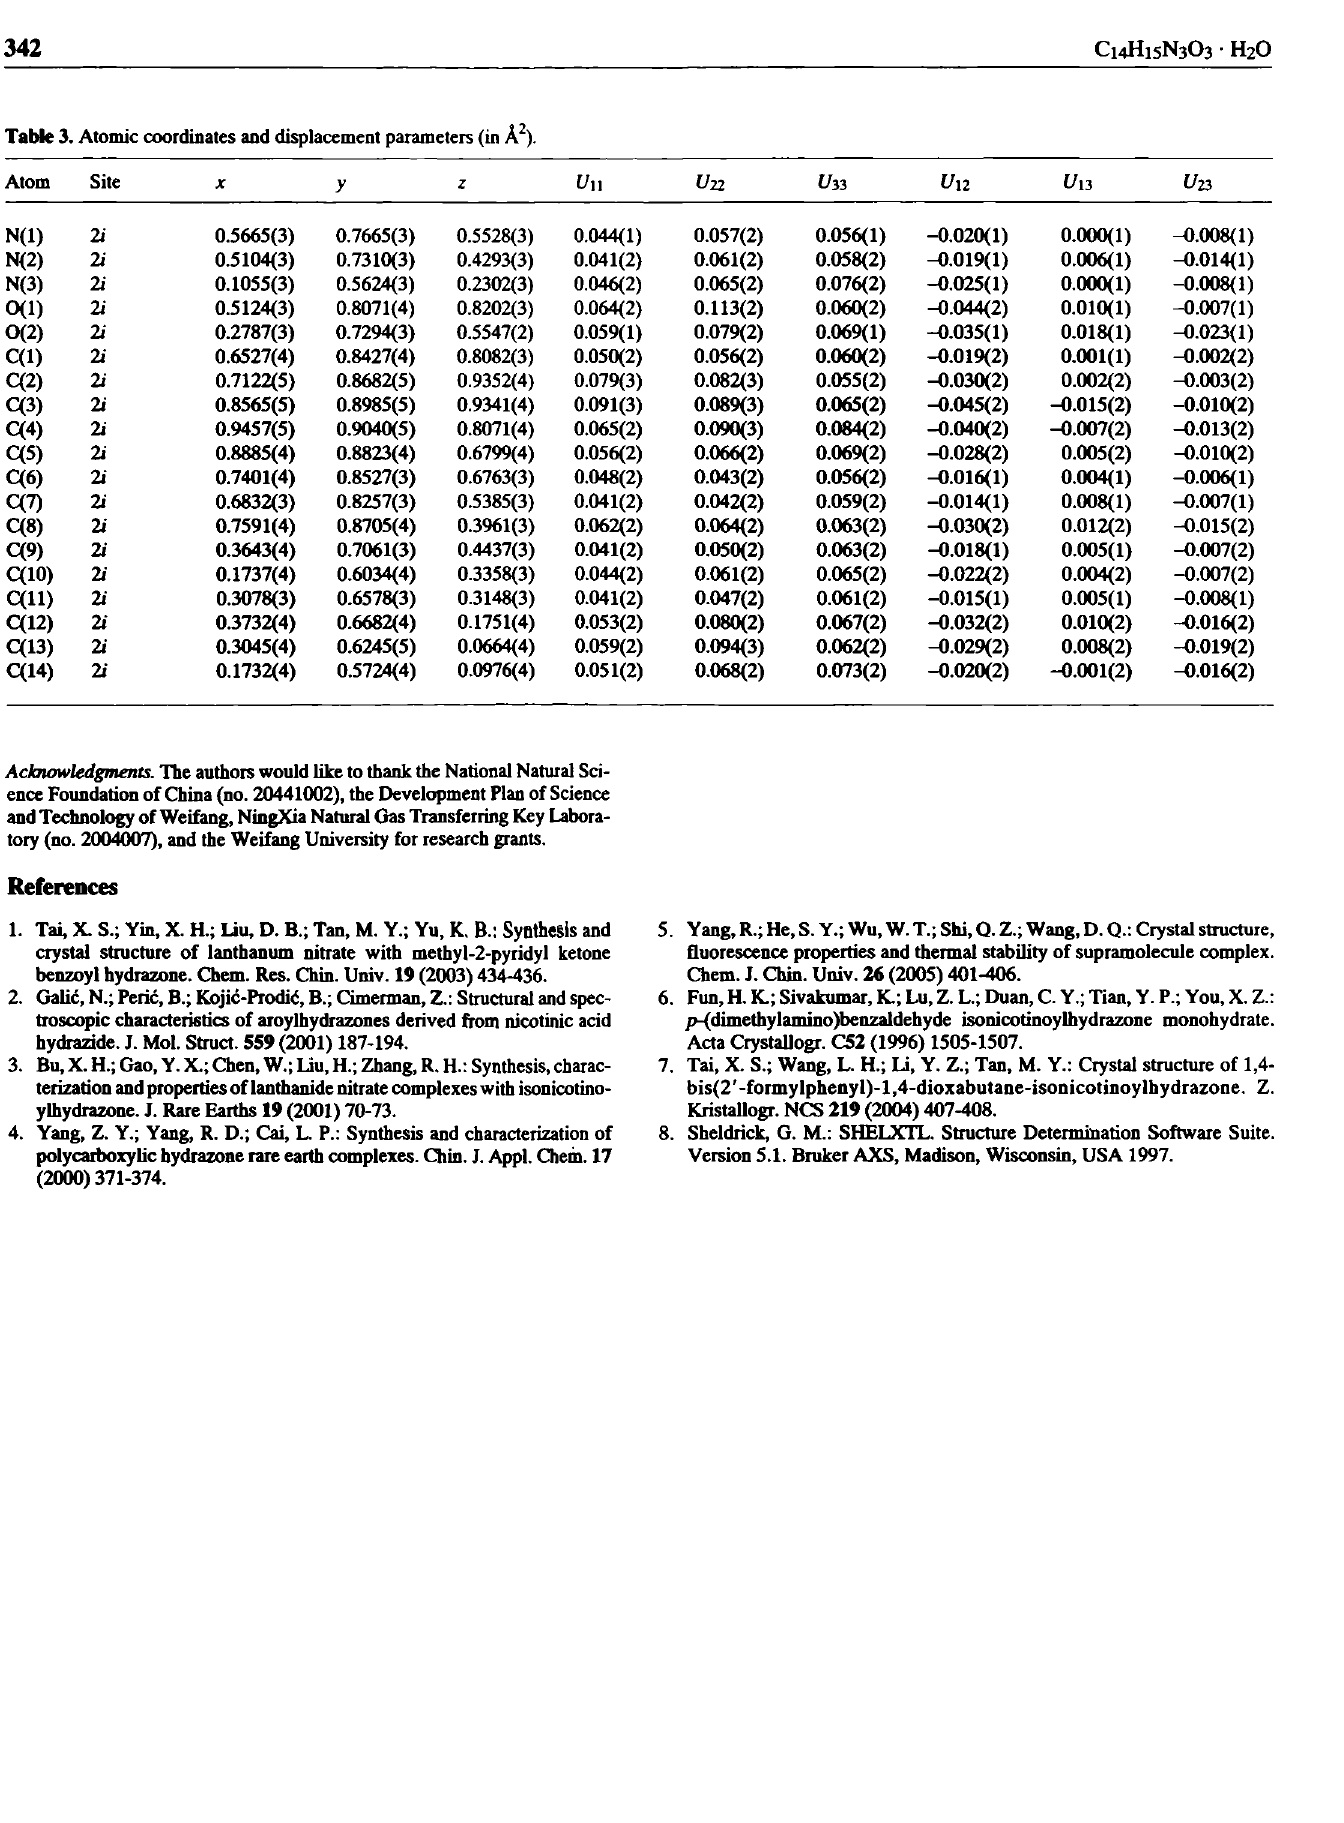
Table 3. Atomic coordinates and displacement parameters (in Ä 2